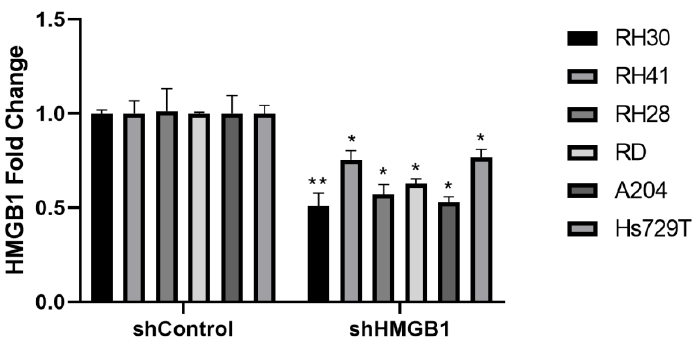
Figure 4. HMGB1 expression levels in RMS cell lines after HMGB1 knockdown. The HMGB1